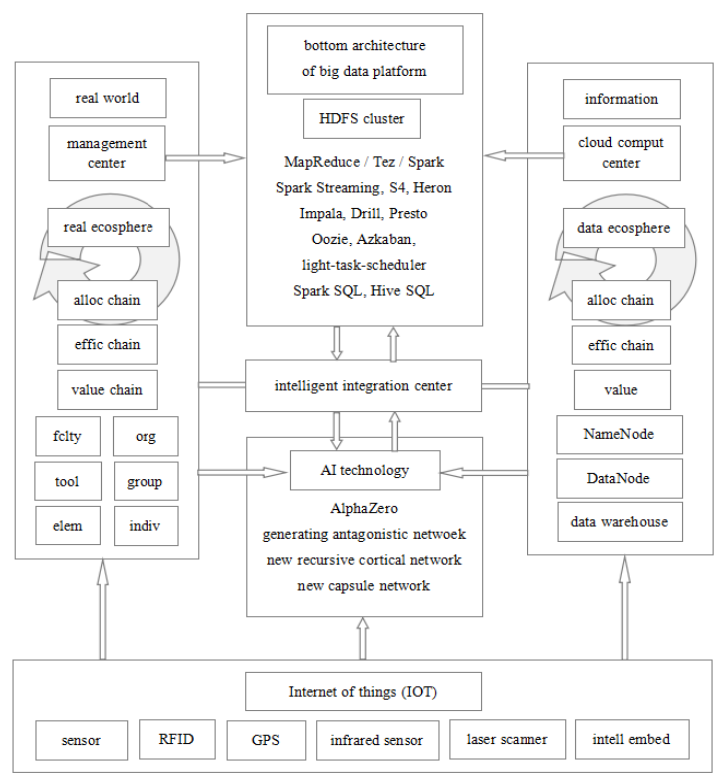
Fig. 6. Integration between actual and information ecospheres with IOT, Artificial Intelligence Technology and Big Data